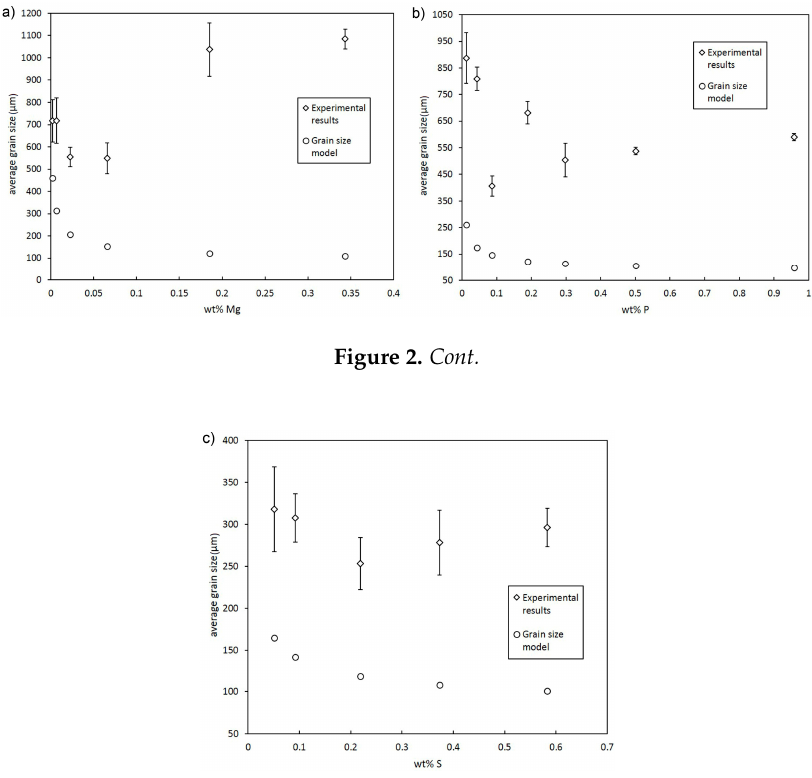
Figure 2. Grain size as a function of Mg ( a ), P ( b ) and S ( c ).